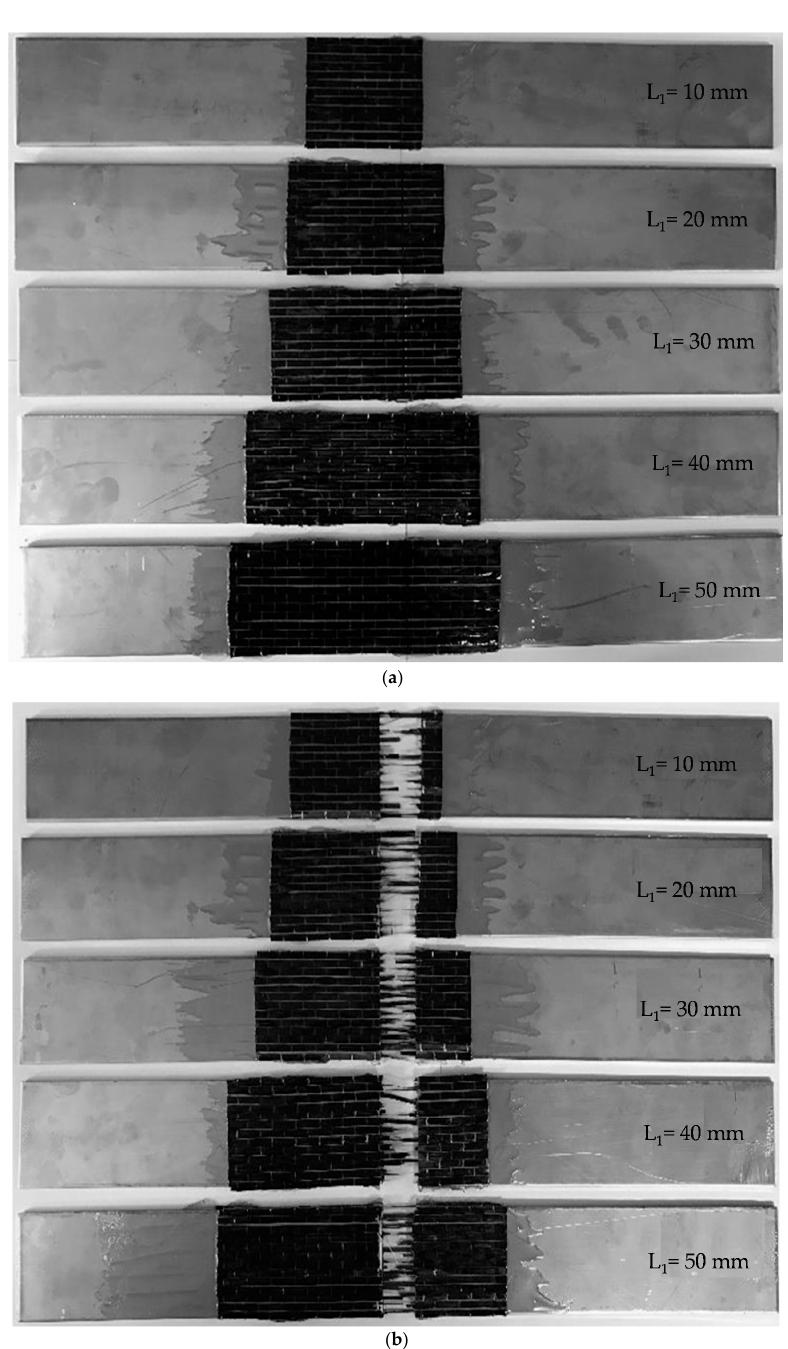
Figure 2. Double strap joints (DSJs) prepared for experiments ( a ) before the test; ( b ) after the test.